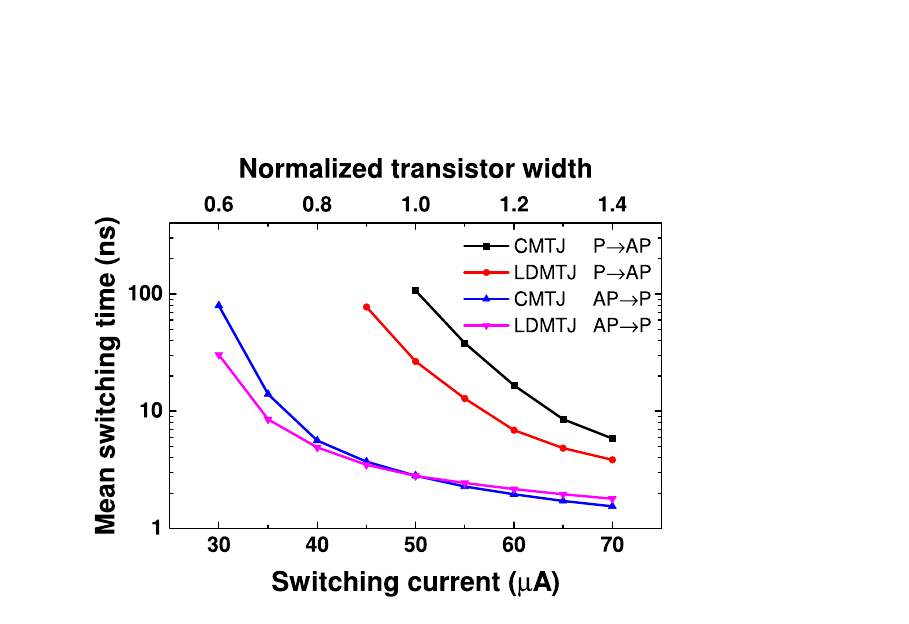
Figure 3. Mean switching time of the CMTJ and LDMTJ devices. Each point on the plot is averaged over 1000 simulations. Top axis shows the effective transistor width normalized to the width required to maintain the current of 50